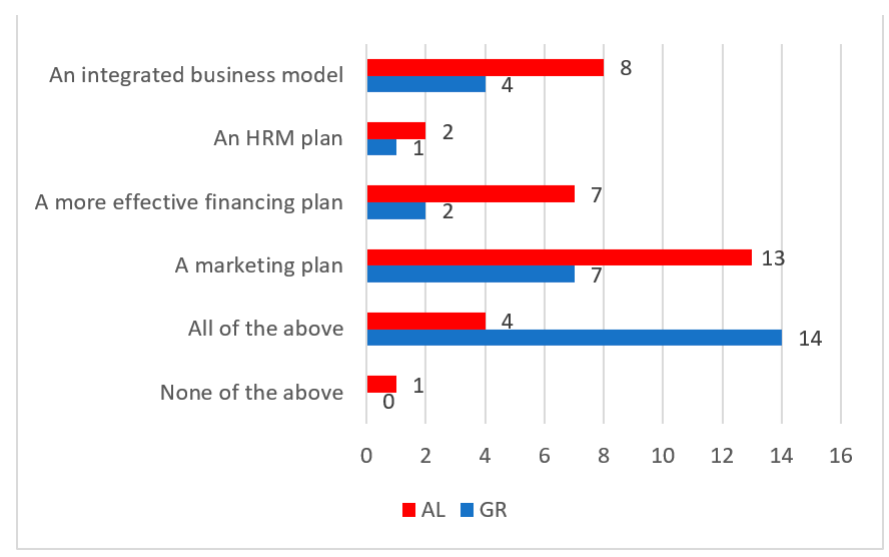
Figure 4. Business acceleration program effectiveness on strengthening organizational skills.